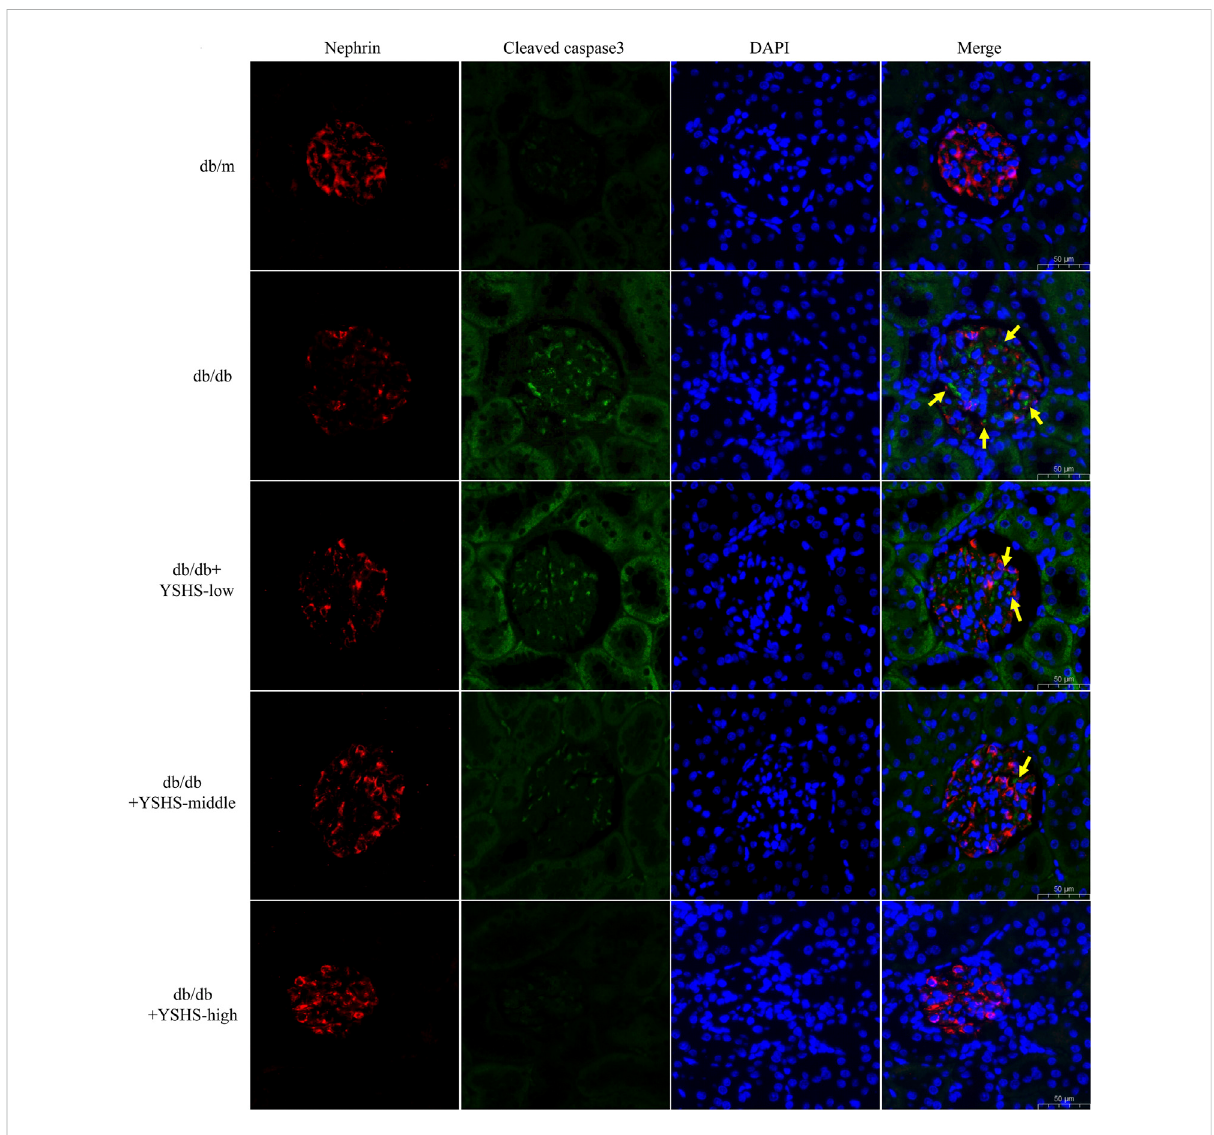
FIGURE 3 Immuno fl uorescence detection of the expression level of cleaved caspase-3 in podocytes in the kidney tissue of DN mice. Red indicates the podocytemarkernephrin,greenindicatescleavedcaspase-3,andyellowarrowsindicatecleavedcaspase-3stainingsitesinnepherin+cells;thesize of the scale is 50 μ